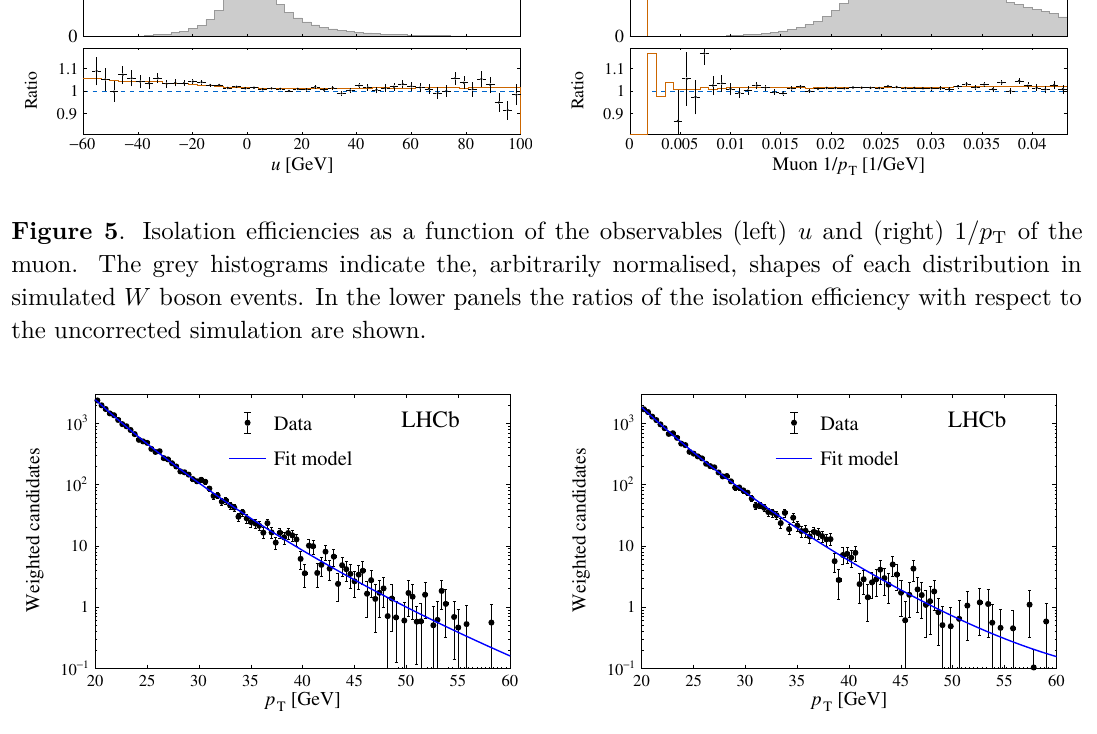
Figure 6 . Weighted p T spectra of the samples of (left) positively and (right) negatively charged hadron candidates. The fit results are